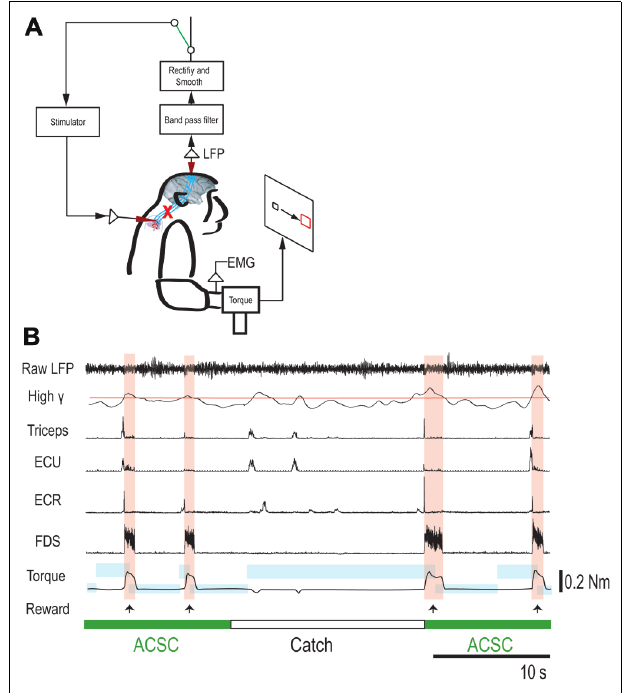
FIGURE 3 | Brain-controlled intraspinal stimulation below the lesion. (A) Schematic shows local field potential (LFP) in motor cortex gating trains of electrical stimulation (300 Hz) to a spinal site below the lesion.The switch in the recurrent loop was opened for catch trials. (B) Four successful trials with the artificial corticospinal connection (ACSC, green) and one catch trial (white). During the catch trial, the monkey made several unsuccessful attempts to produce wrist torque, as seen in the EMG and torque.The blue rectangles indicate duration and force range of target.The pink vertical bars indicate duration of electrical stimulation in the spinal site. The red line in second trace represents the threshold for spinal stimulation. From top, raw LFP in motor cortex, rectified and smoothed high-gamma LFP (90–160 Hz), EMG from four muscles (abbreviations as in Figure 2 ), and wrist torque. Arrows indicate times of successful task completion and reward.